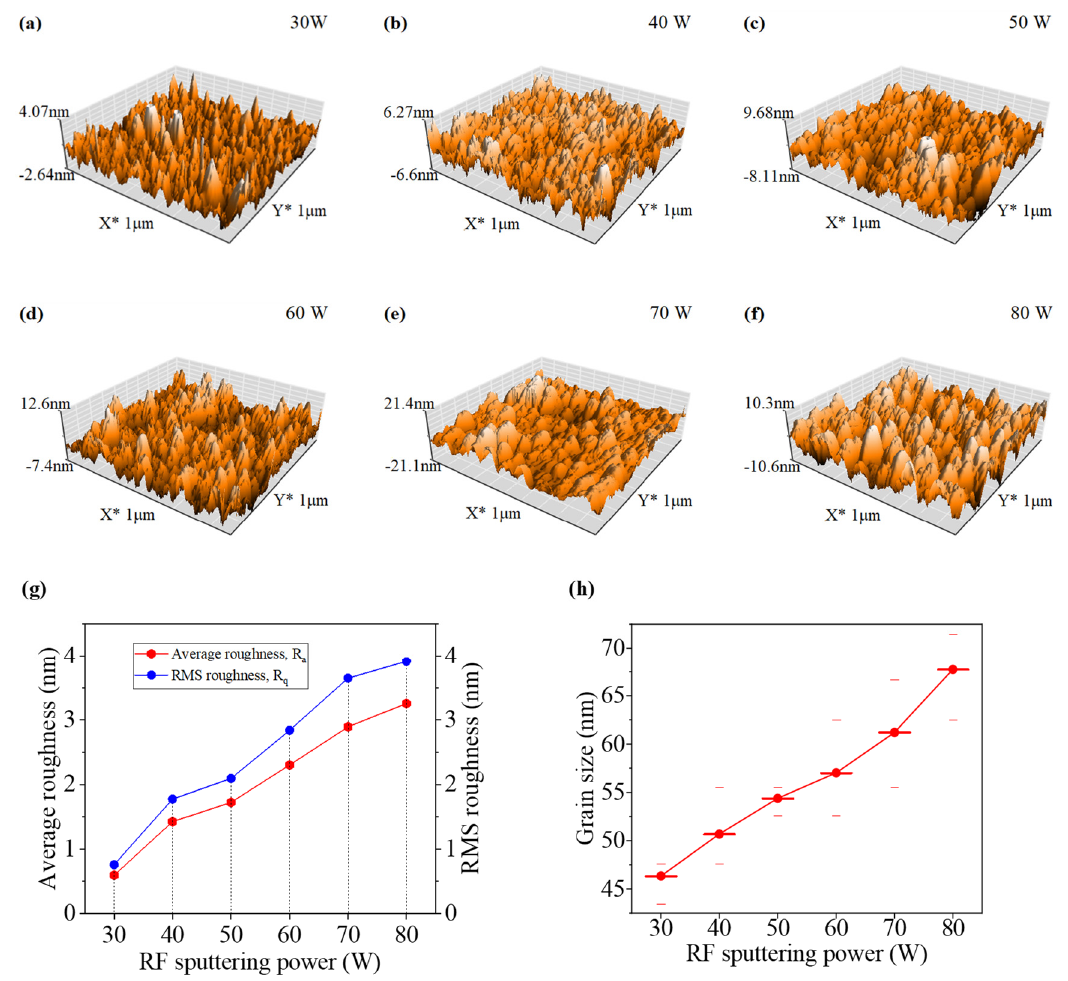
Figure 2. 3D AFM images of the WO x thin films, deposited at different sputtering powers: ( a ) 30 W, ( b ) 40 W, ( c ) 50 W, ( d ) 60 W, ( e ) 70 W, ( f ) 80 W. ( g ) Roughness variation and ( h ) grain size variation due to different RF sputtering powers. Table 1. Morphological properties of WO x films.